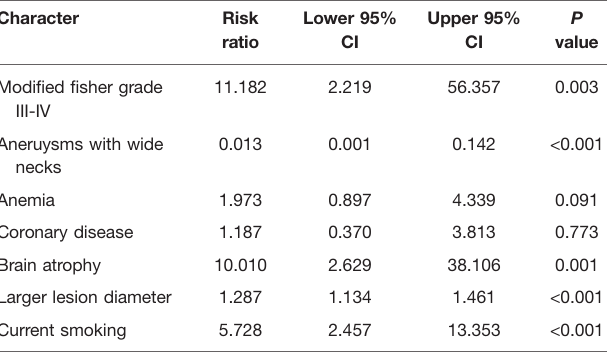
TABLE 5 | Multiple logistic regression analysis for the factors related to the presence of “ typical ” and “ atypical ” symptoms in elderly patients with ruptured